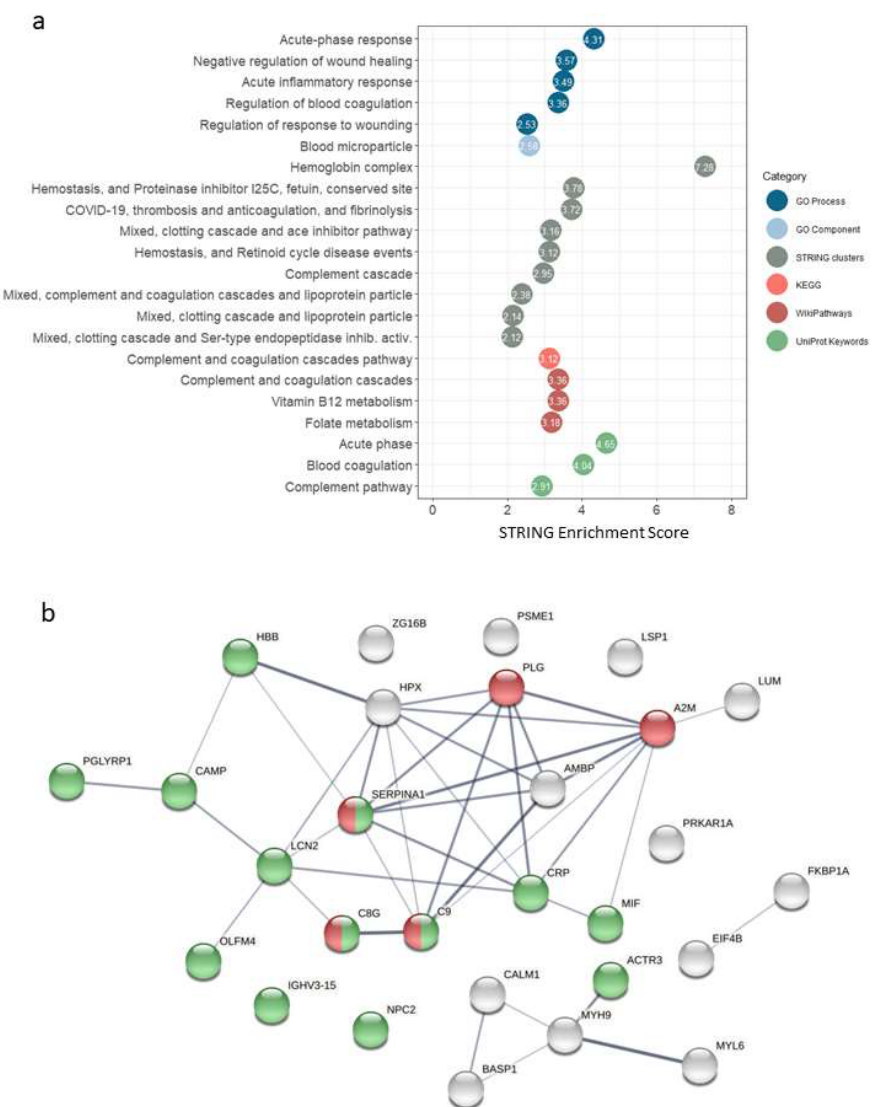
Figure 2. Functional analysis of the quantitative results. ( a ) Functional analysis in STRING, showing enriched terms (FDR < 0.01) for different categories (GO Process, Go Component, STRING clusters, KEGG, WikiPathways and UniProt Keywords). ( b ) STRING interaction network for the mapped differentially abundance proteins. Nodes represent proteins, edges represent protein–protein interactions (line thickness indicates the strength of data support for each interaction). Highlighted nodes: complement and coagulation cascades (KEGG pathway hsa04610) in red; immune response (GO Biological Process GO:0006955) in green.